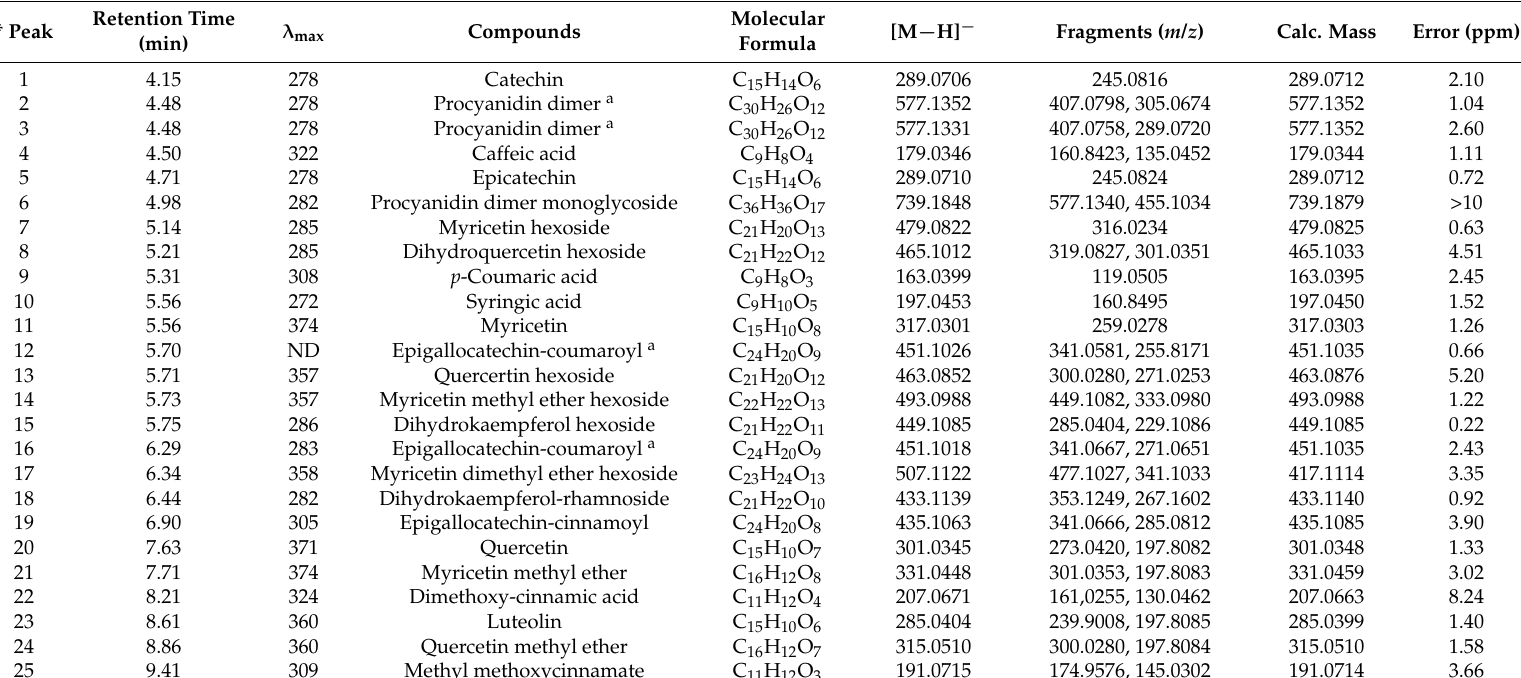
Table 2. Identification of compounds present in the fraction Fr 2 SySFV by UPLC-QTOF/MS E